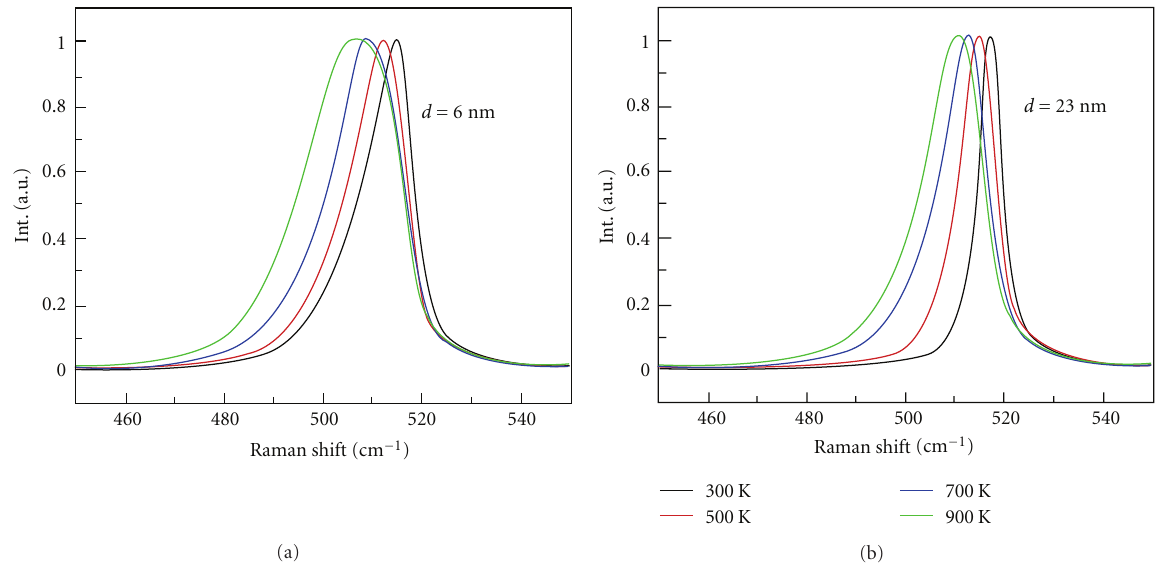
Figure 9: Calculated Raman line shape of the 520 cm − 1 band of Si nanowires subjected to laser inhomogeneous heating. The focal spot size is 1 μ m in the micro-Raman focal plane. Results are calculated using (10) at the di ff erent peak temperatures indicated for (a) D = 6 . 0 nm and (b) D = 23 nm nanowires